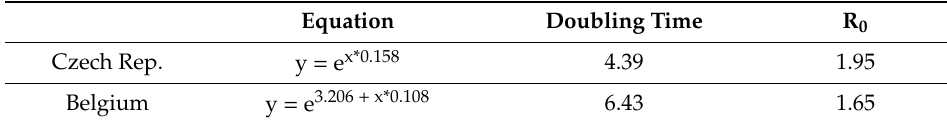
Table 1. Exponential equations, doubling time values, and R 0 values for Czech Republic and Belgium epidemics.